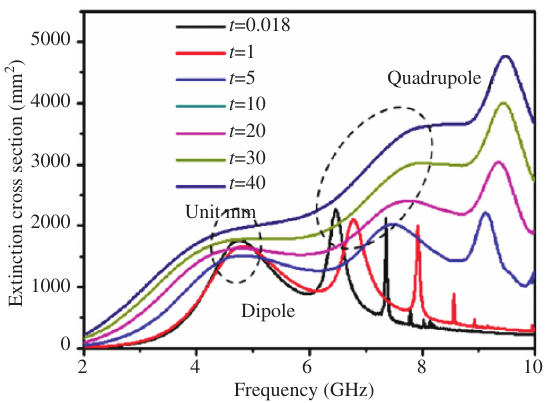
Figure 24: The impacts of disk thickness t on the LSP behaviors of the planar textured metallic disk, in which the thickness is defined as 0.018 to 1, 5, 10, 20, 30, and 40 mm, respectively. Reproduced from [46] with permission.